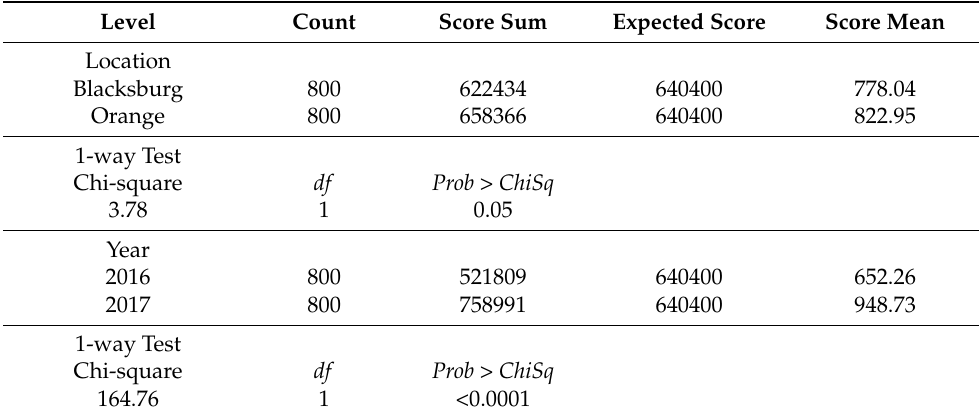
Figure 1. Frequency distribution of KTI concentration (mg/g) of in 200 F 3:5 lines developed from a cross between Glenn (normal KTI) and PI 547,656 (low KTI) planted in Blacksburg and Orange, VA in 2016 and 2017. Table 4. Kruskal–Wallis test of Kunitz trypsin inhibitor concentration (KTI) among 200 F 3:4 lines (2016) planted in Blacksburg and Orange, VA in 2016 and